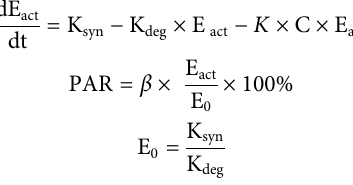
Frontiers in Pharmacology |